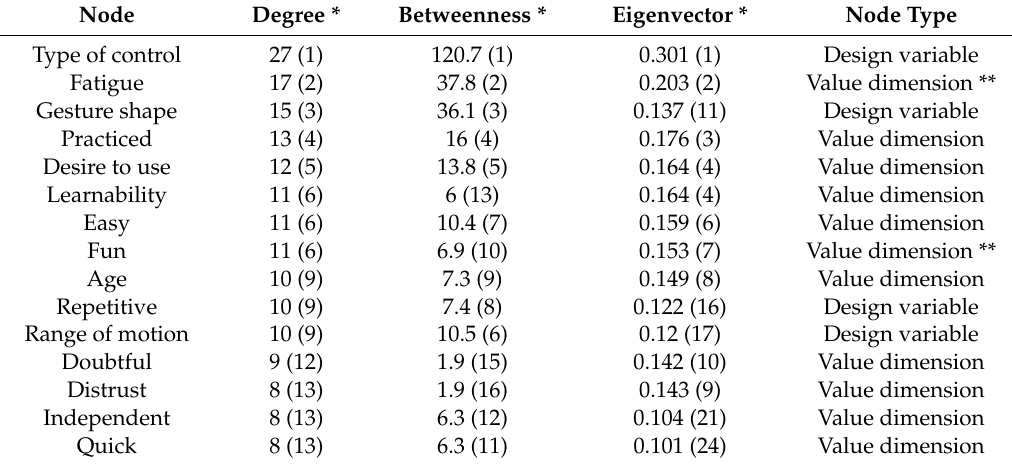
Table 2. Centrality of representative nodes associated with convenience.